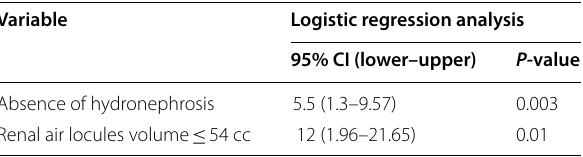
Table 2 Multivariate analysis of factors affecting the success of conservative management in patients with EPN Variable Logistic regression